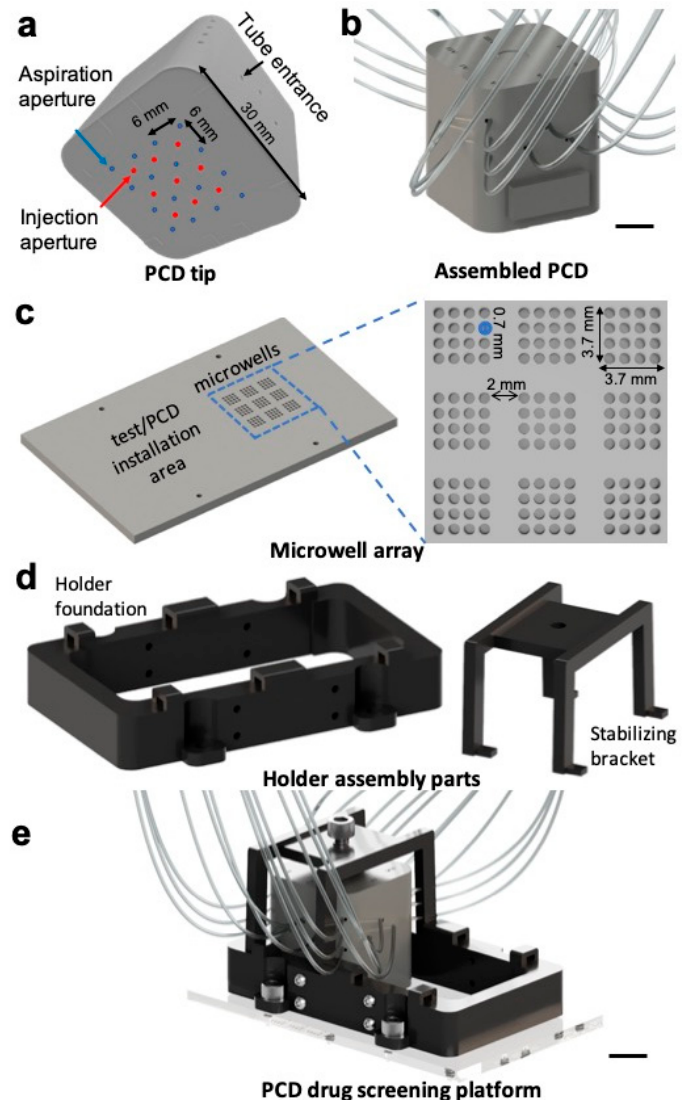
Figure 1. CAD figures of the drug screening platform parts created using Fusion 360 software: ( a ) a 3D printed nine-pixel PCD tip with injection and aspiration apertures. Each square-shaped pixel consists of an injection aperture in the centre of the square and four aspiration apertures on the corners; ( b ) fully assembled PCD showing the tubes connected to the PCD; ( c ) micromachined microwell array featuring 144 microwells to accommodate the tumour models; ( d ) 3D printed holder assembly parts with a holder foundation (left) that is attached to the microwell array slab and a bracket to stabilize the PCD once installed over the microwells (right), and ( e ) schematic of the fully assembled PCD drug screening platform. Scale bars = 1 cm.